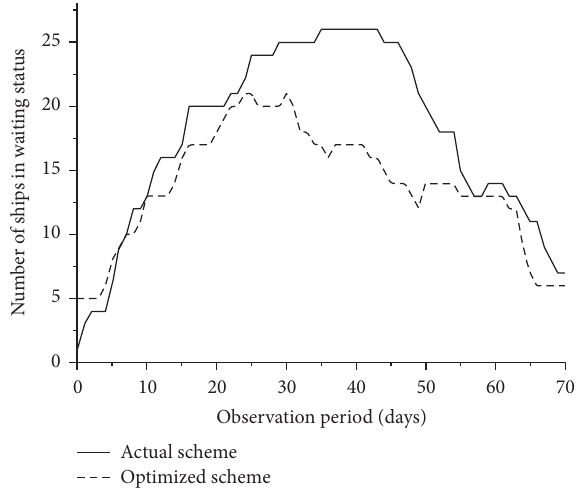
Figure 6: Comparative analysis of ships in waiting status.